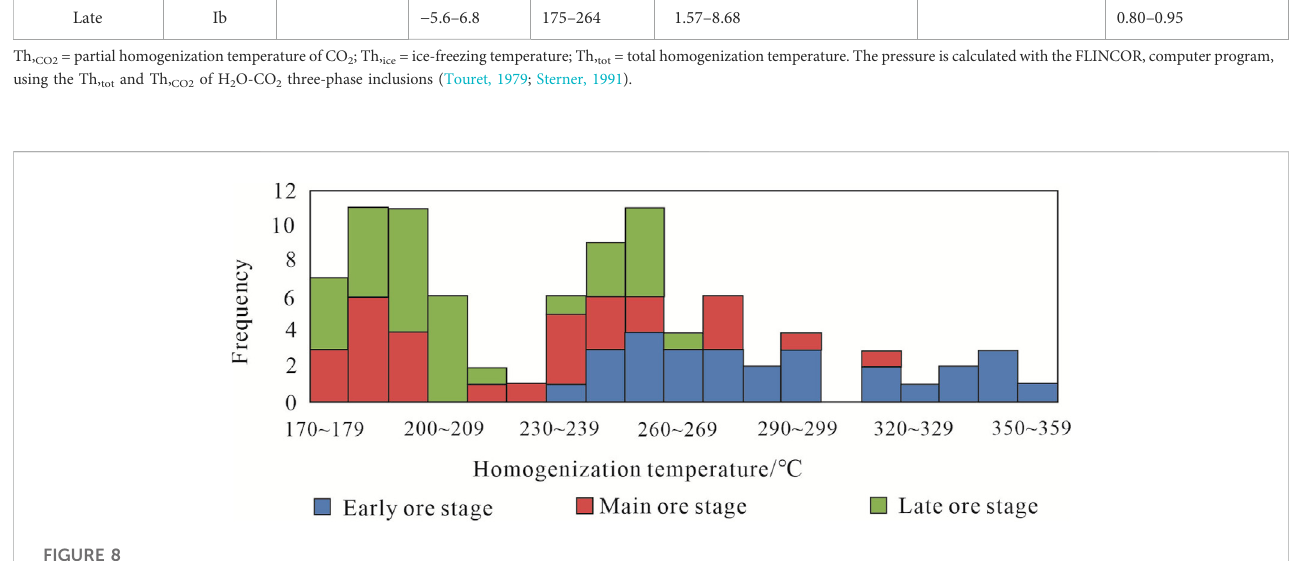
(Figure 7I) and type Ib (L H2O + V CO2 ) FIs (Figure 7I). Type IIa (L H2O +